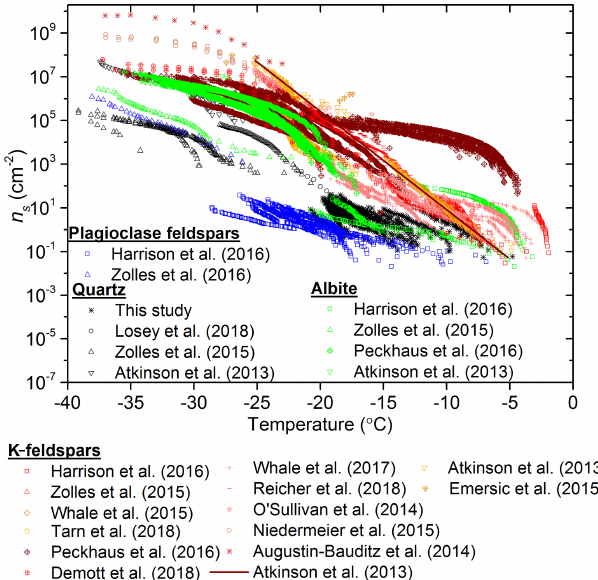
Figure 6. Plot of n s versus temperature for quartz and feldspar lit- erature data, together with the quartz data from this